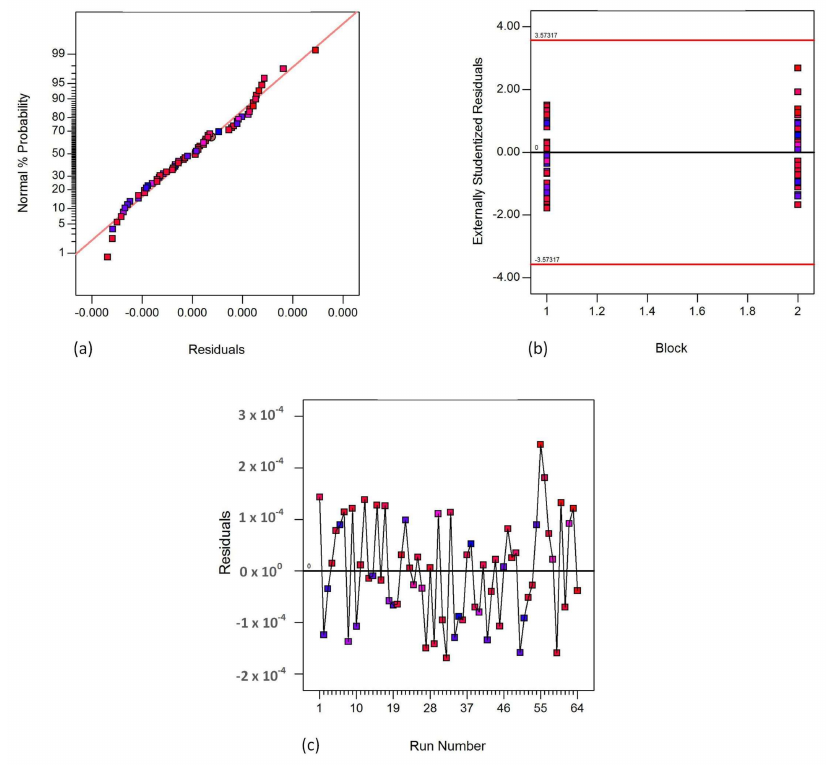
Figure 7. Fisher assumptions ( a ) residual normality; ( b ) equality of variance and ( c ) run-order independence for flexural